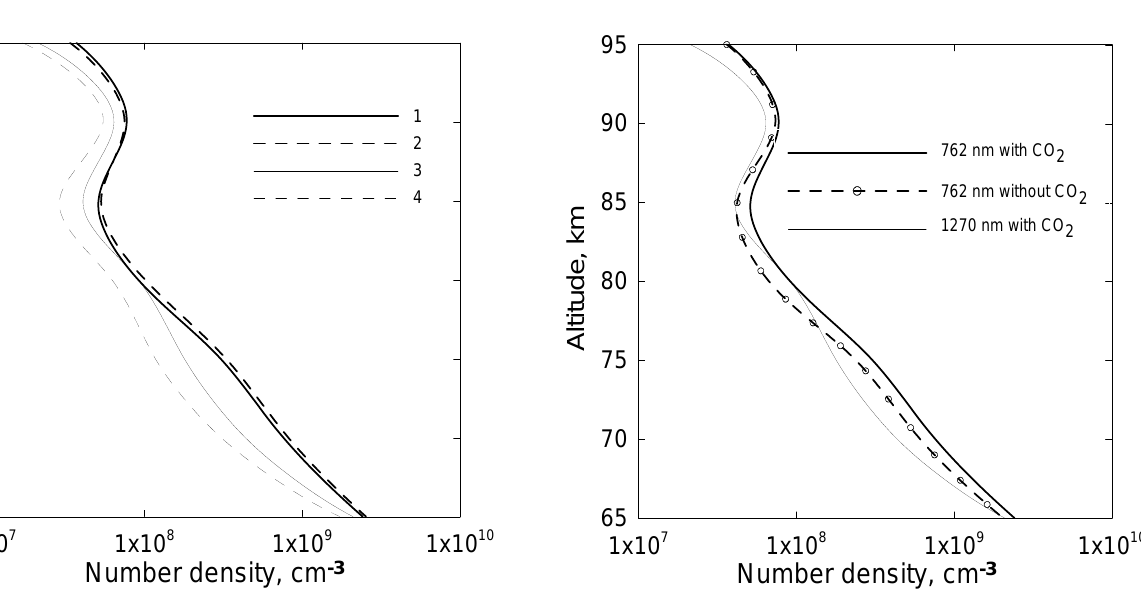
Fig. 11. Altitude profiles of ozone concentration retrieved from si- multaneous observations of O 2 emissions at 762nm and 1.27 µ m in METEORS (Mlynczak et al., 2001). Retrievals in accordance with our model: taking into account CO 2 altitude profile – solid lines, with CO 2 mixing ratio equal to 0 – dashed